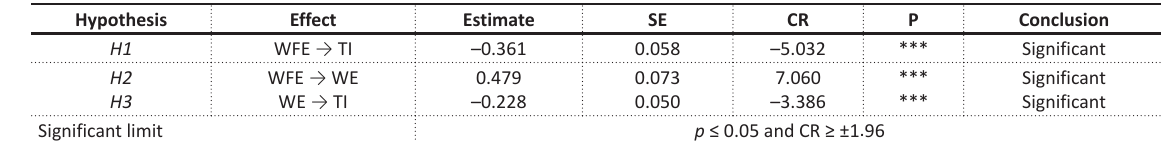
Table 2. Results of research hypotheses